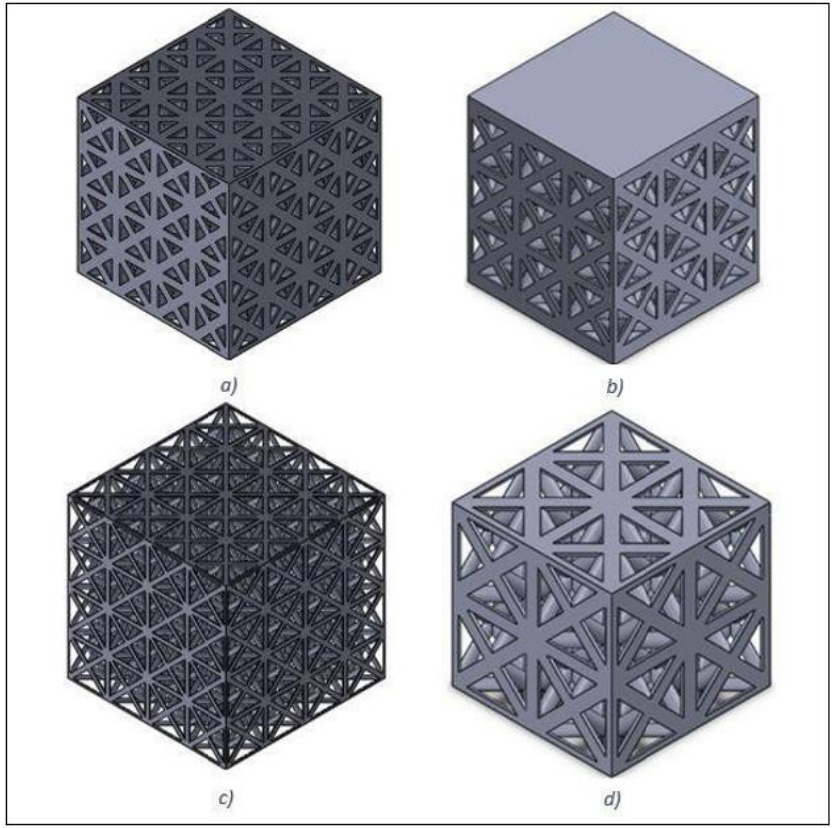
Figure 3. CAD models created in Solidworks 2018 of compression test samples representing face- centred cubic lattice structures of ( a ) Lattice 1; ( b ) Lattice 4; ( c ) Lattice 5; and ( d ) Lattice 6. Each sample was imported into Abaqus 2017 (Dassault Systemes, Velizy-Vilacoublau, France) to conduct FEA, with C3D8R quadratic elements chosen for the lattice structure that was 1 mm in size. The material properties of the Ti-6Al-4V titanium alloy were obtained through the experimental testing of fabricated solid compression samples. A discrete rigid, 2D planar part using R3D4 elements was created to represent the top plate during a compression test, and an assembly was created consisting of the sample and the plate. A mesh sensitivity analysis was carried out to optimise the element size and computational time at which an accurate solution could be